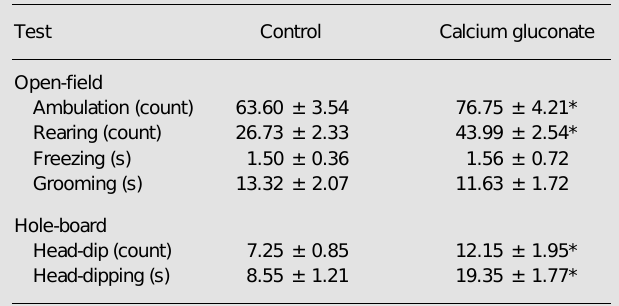
Table 2. Open-field and hole-board behavior of rats receiving distilled water containing 1% calcium gluconate for 3